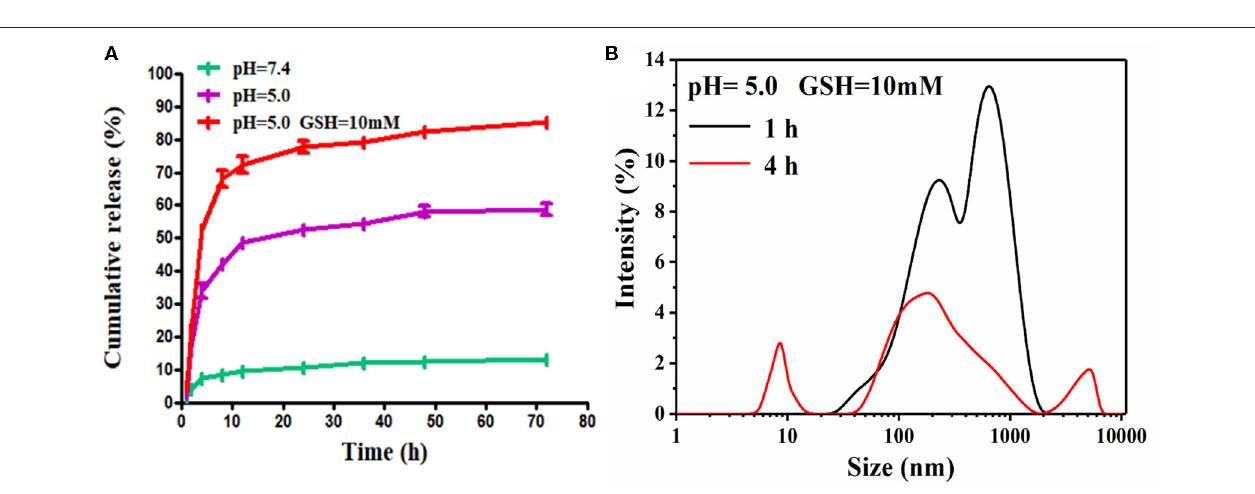
the co-assembly of FDA-approved Poloxamer 188 (a kind of PEG-containing amphiphilic polymer, PEG-PPG-PEG), with the nanoscale HY/SS-COFs formed by ultrasonic